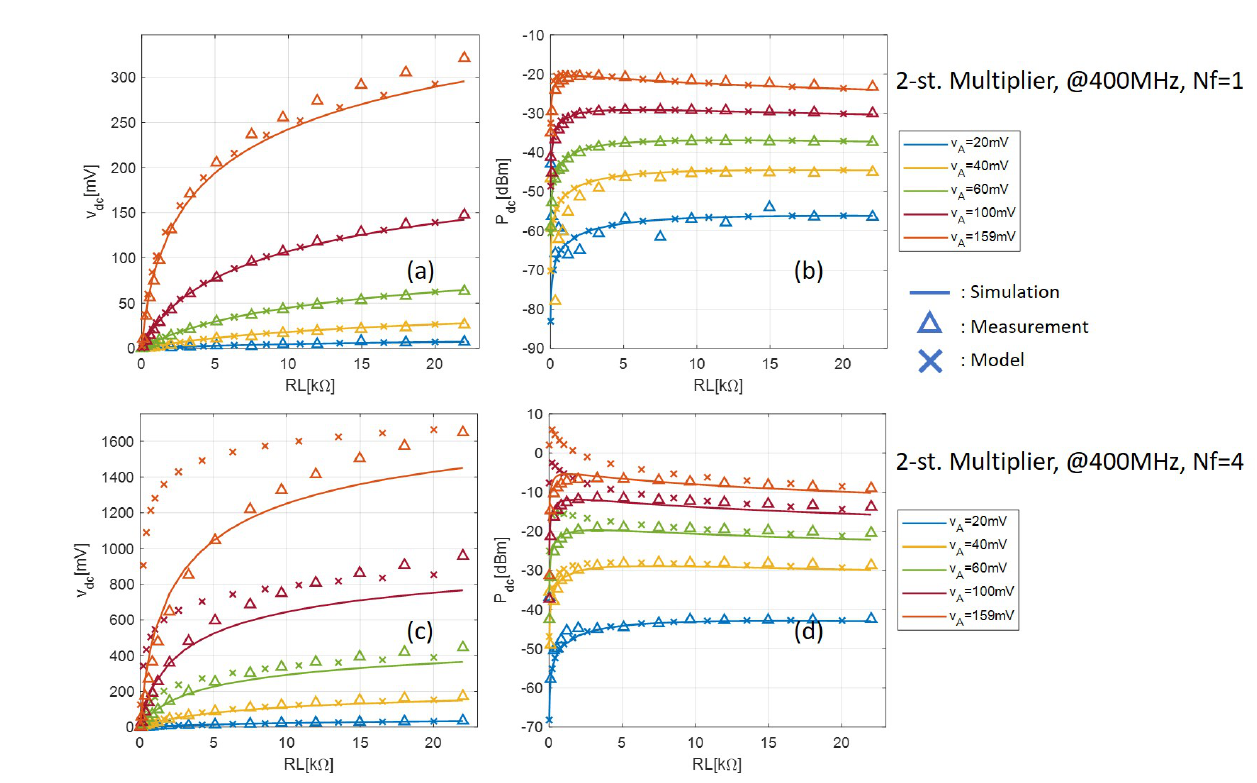
Figure 9. Comparison between measurement, simulation, and analytical model of the two-stage multiplier. Output DC voltage with ( a ) N f = 1 and ( c ) N f = 4; output DC power with ( b ) N f = 1 and ( d ) N f =